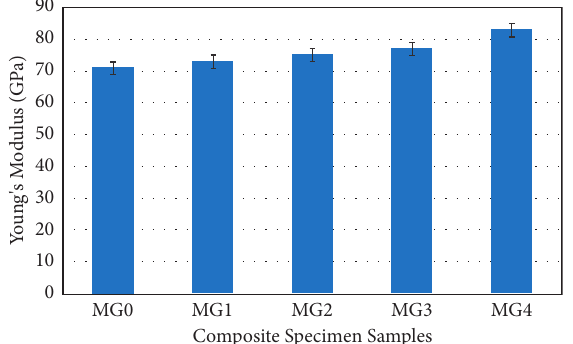
Figure 6: Variation on Young’s modulus of composite specimens.